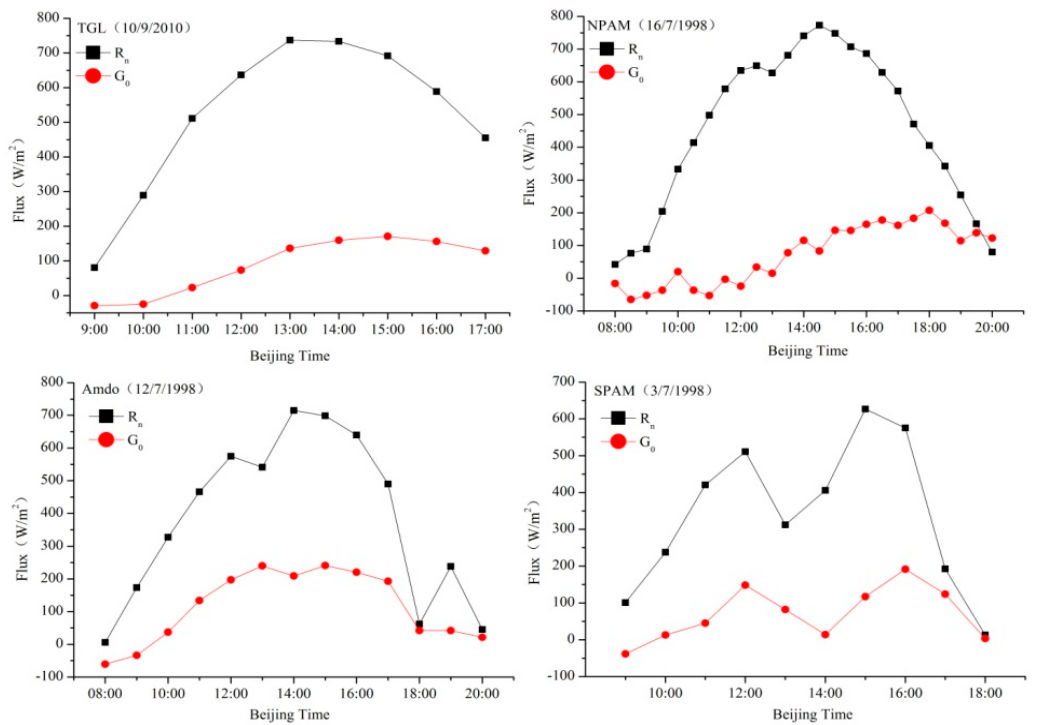
Figure 4. Daily fluctuations of net radiation R n and ground surface soil heat flux G 0 at TGL, NPAM, Amdo and SPAM sites on a sunny day.